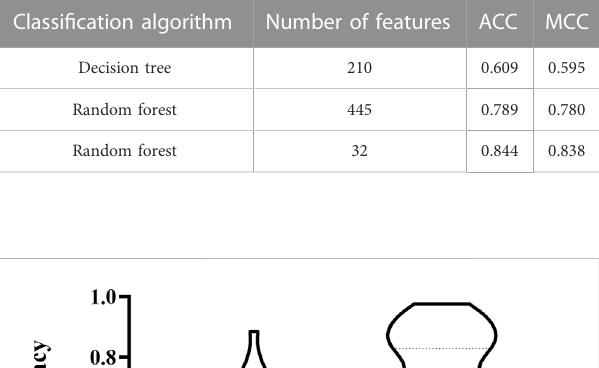
FIGURE 3 Violin plot to show the performance of two optimal classi fi ers on all cell types. RF classi fi er is evidently superior to DT classi fi